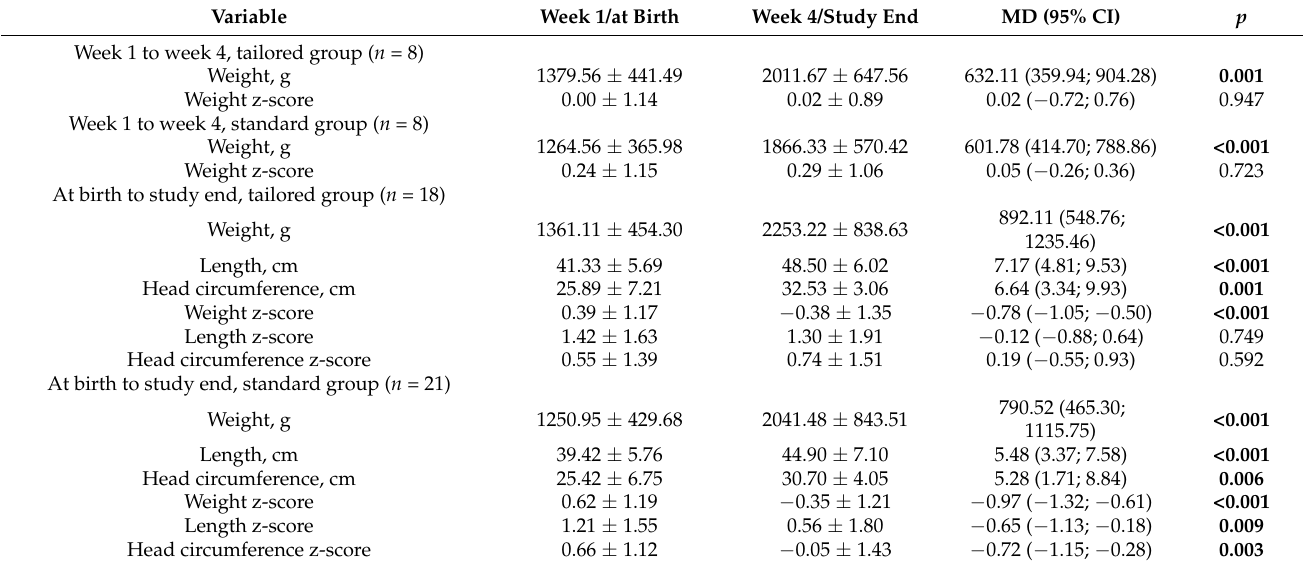
Table 3. Weight, length, and head circumference development for the first 4 weeks.